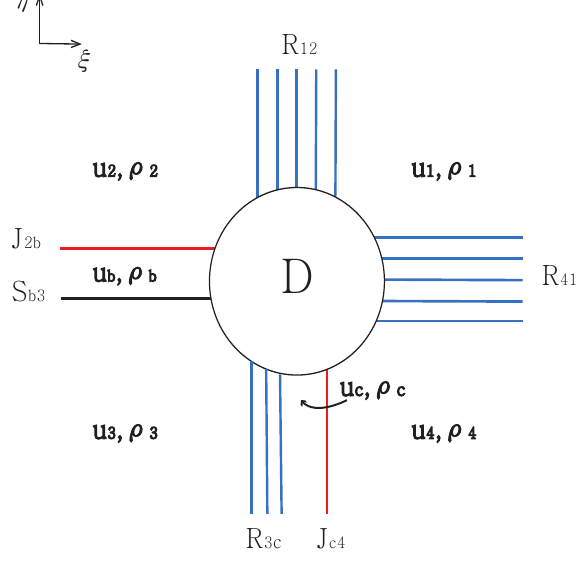
Figure 2. The solution at infinity ( R + JS + RJ + R ) for u 2 < u 3 < u 4 < 0 < u 1